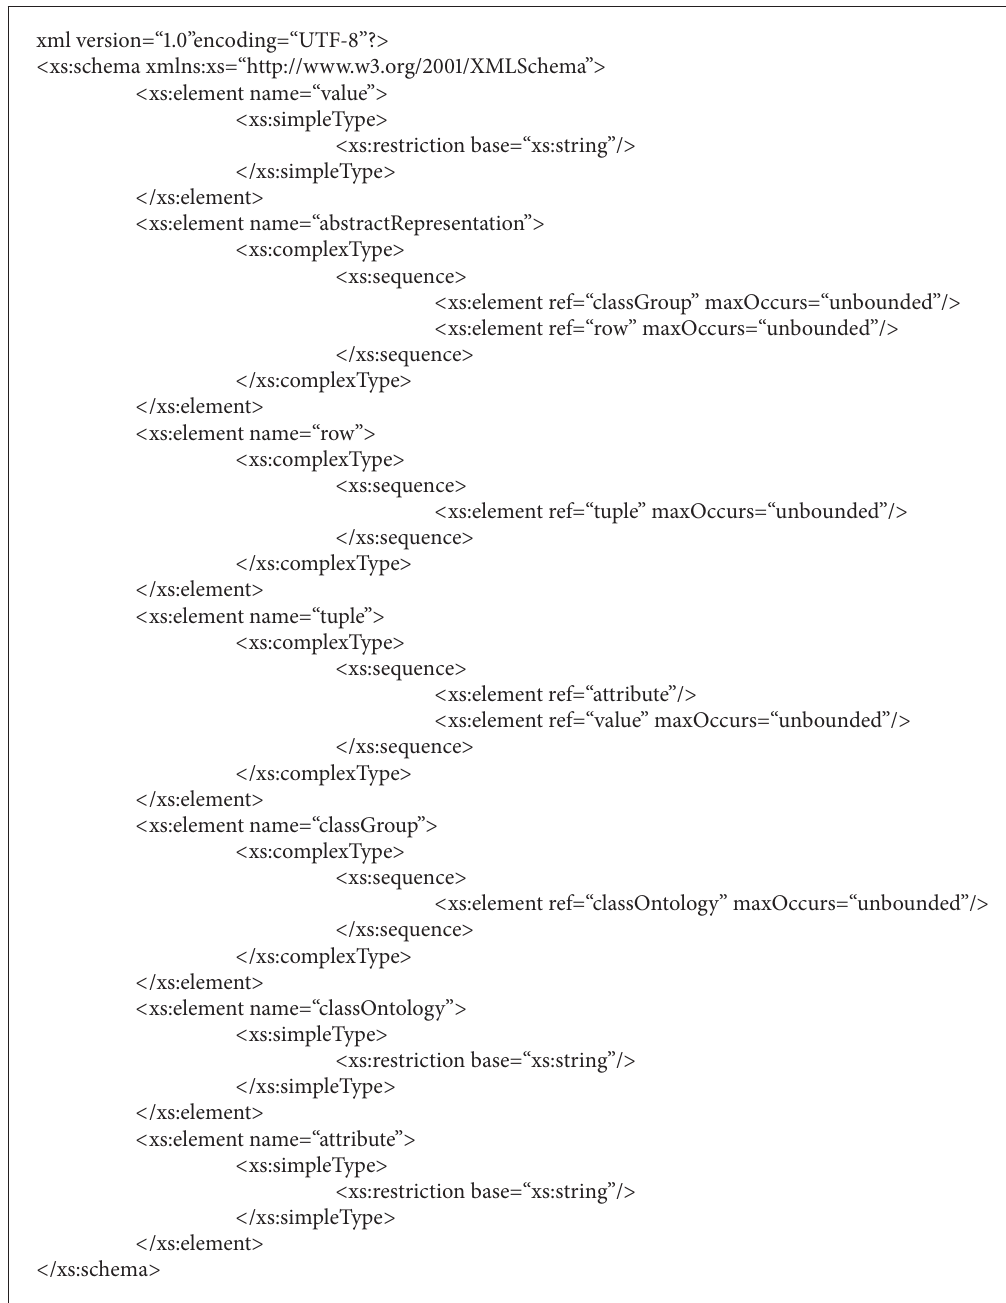
Algorithm 1: XML Schema of the internal representation